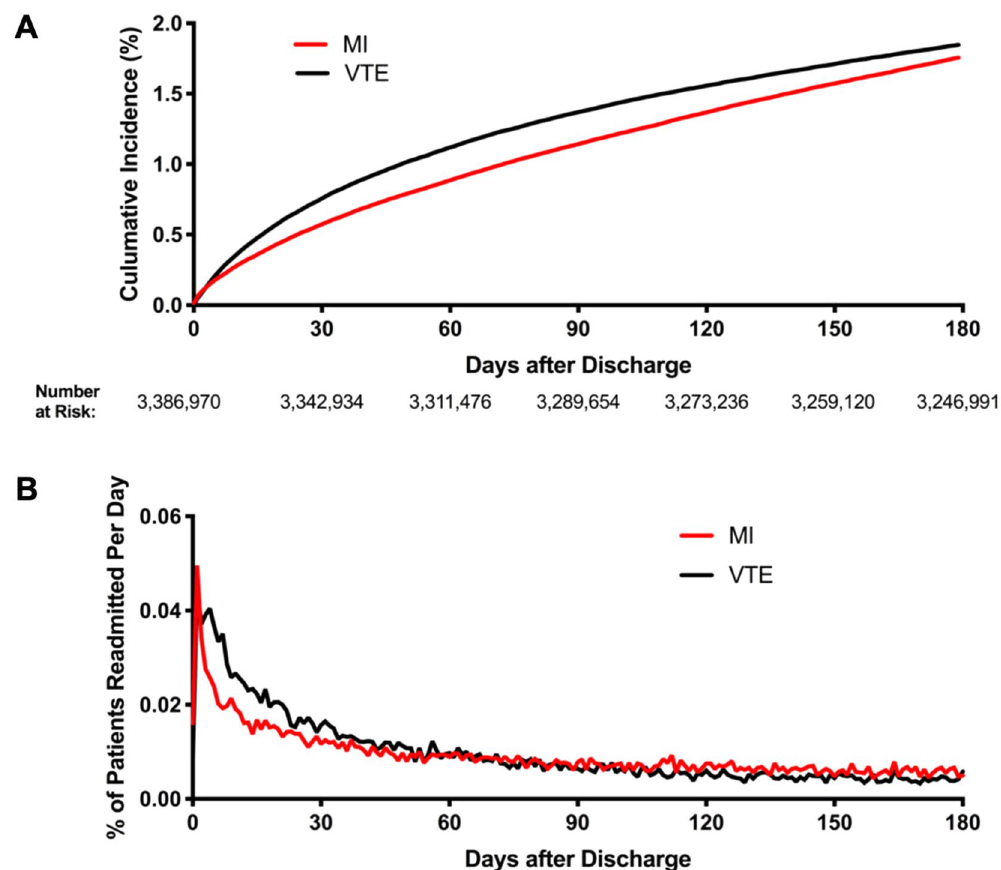
Figure 1. Cumulative incidence of first readmission for MI and VTE in the first 180 days after discharge following respiratory infection (Panel A ) and the daily proportion of patients with readmission for MI and VTE (Panel B